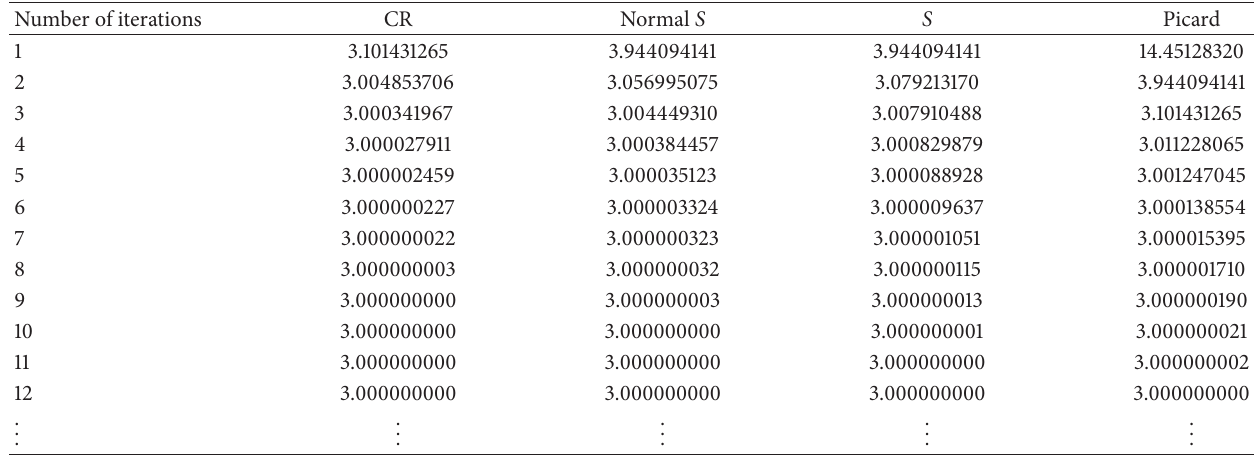
Table 2: Comparison speed of convergence among various iteration methods.